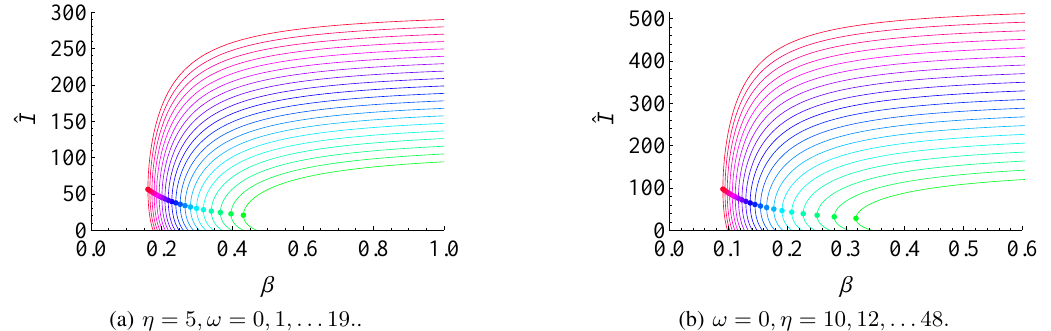
Fig. 2: Bifurcation diagrams for 20 different values of (a) ω and (b) η in the case when ( θ + µ + σφ ) 2 < σ ( µ + γ )(1 − σ ) φ . Proposition VI.1 implies that for all η and ω there is a backward bifurcation at R curves move to the left as the immigration parameter increases. We let Λ( x ) = x as µ = 0 . 1 , γ = 12 , θ = 0 . 5 , σ = 0 . 2 , φ = 16 , c = 1 , d = 1 . 8